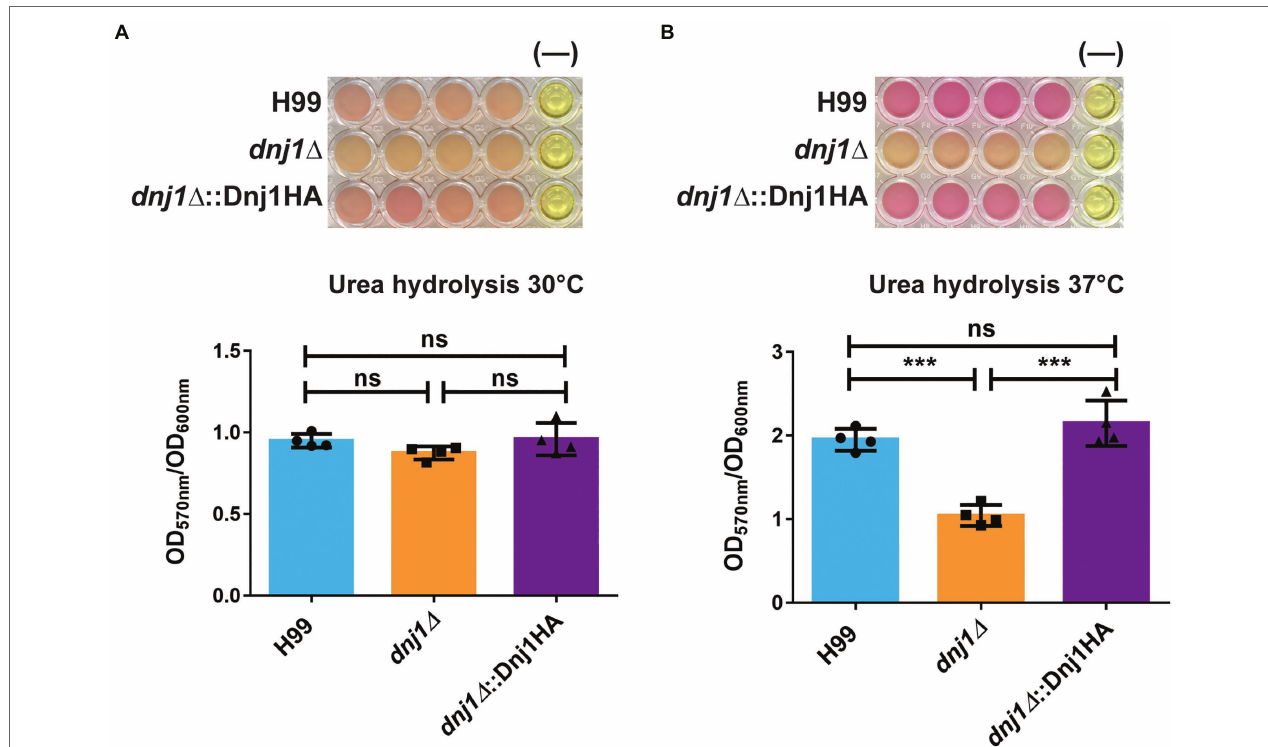
FIGURE 7 | Dnj1 is required for robust extracellular urease activity in C. neoformans . Urease activity was assayed in minimal media containing 2% urea and phenol red as a pH indicator. The alkalinization caused by hydrolysis of urea to produce ammonia was measured by the change in the color of the media from yellow to pink and the OD 570nm of the supernatant. This quantification was normalized to OD 600nm to control for any differences in growth and a representative plate with a negative control ( − ) is shown for both temperatures assayed (A) 30 and (B) 37 ° C. Bars represent the mean OD 570nm of four biological replicates and the error bars indicate the SD. Significance was determined using a one way ANOVA with Tukey’s multiple comparison tests (*** p <